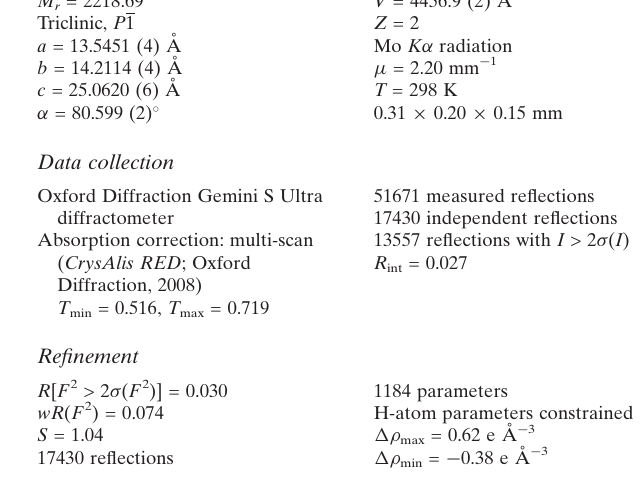
asymmetric unit of the compound